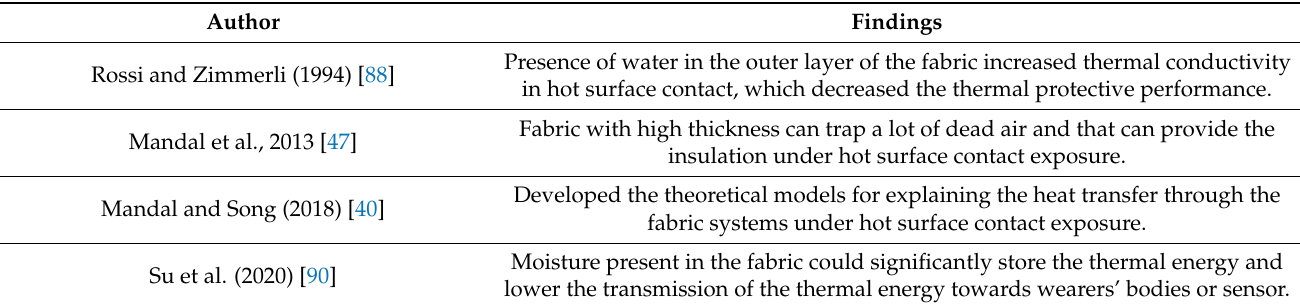
Table 3. Thermal protective performance under hot surface contact